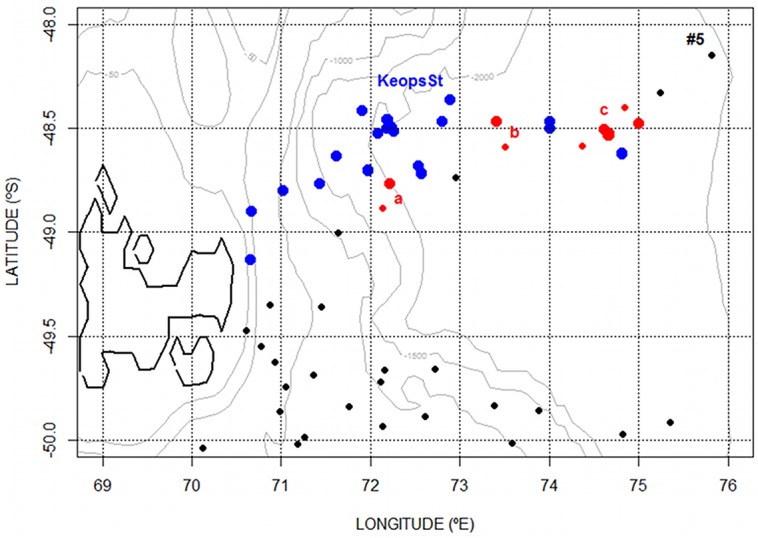
Zoomed location of seal and Keops profiles that have been compared.The selected profiles are in red (large dots = Keops; small dots = Seals). The letters a,b & c correspond to the profiles presented in Fig 3.